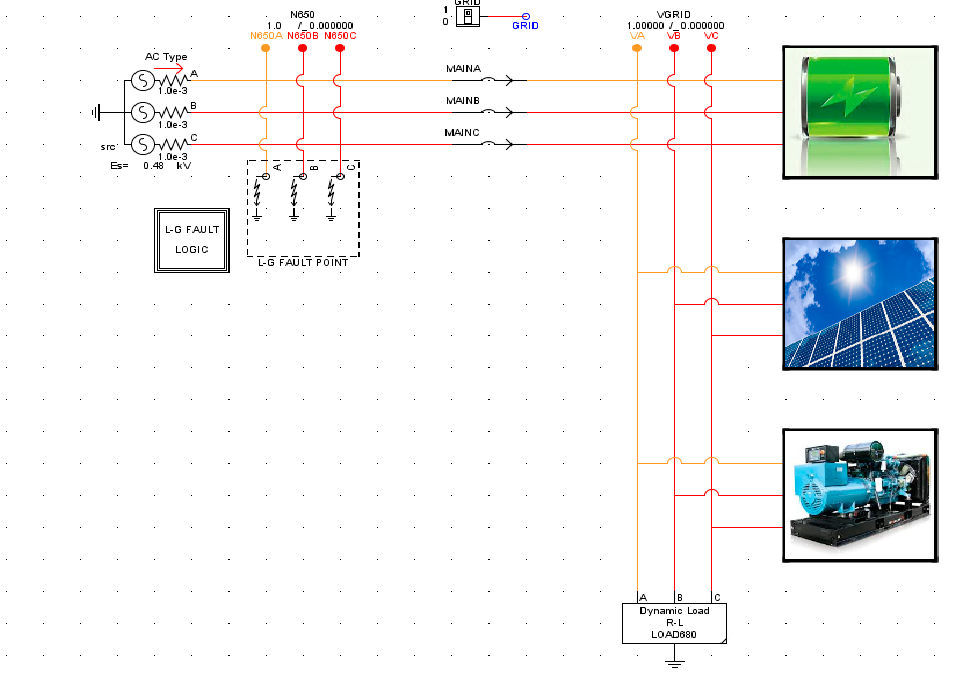
Figure 8. The studied DERs system model built in RSCAD (Interfacing software with RTDS).